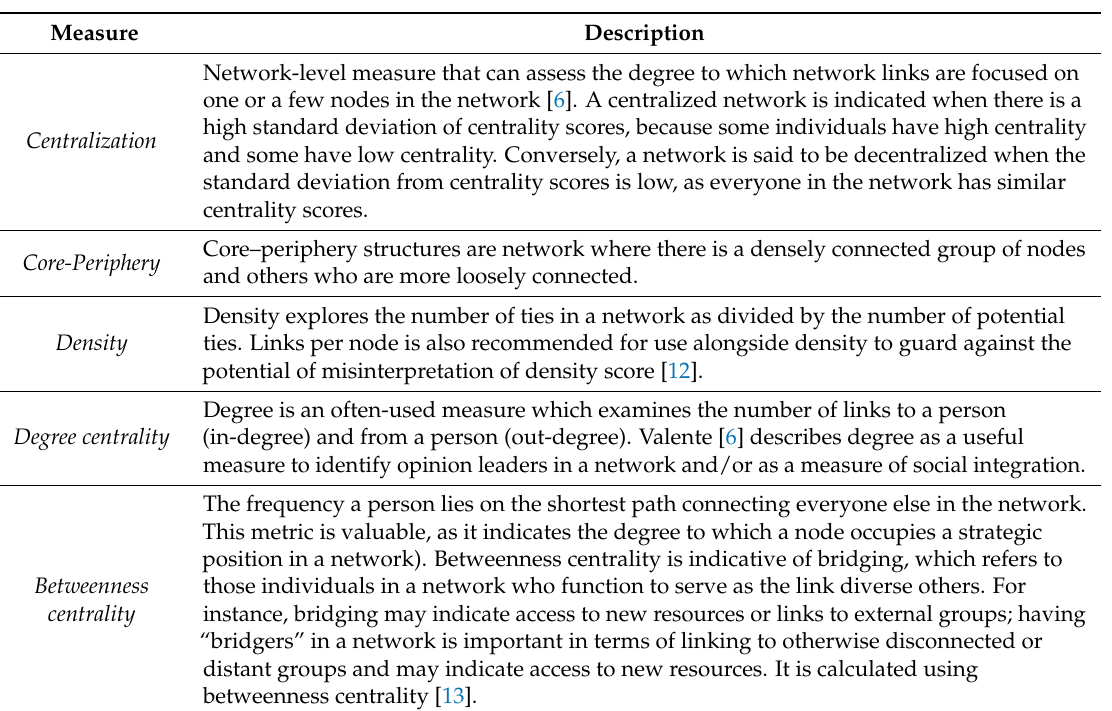
Table 1. Summary of relevant network and node